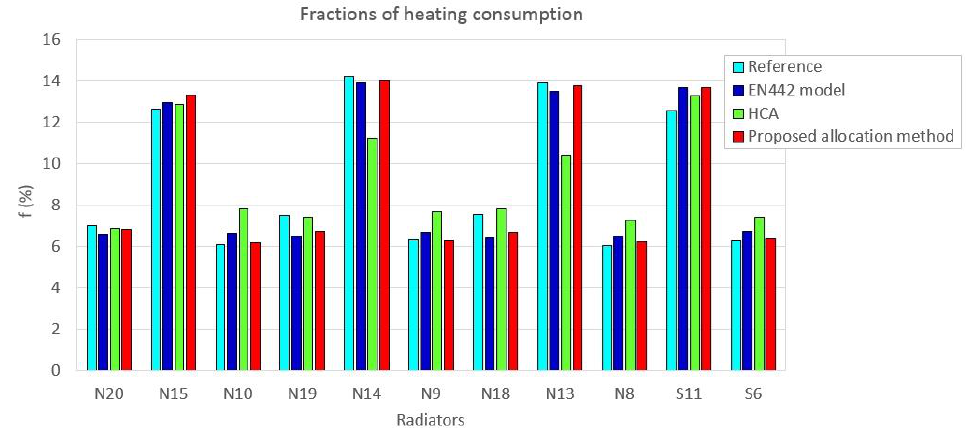
Figure 9. Fractions of heating consumption associated with water radiators. HCA, Heat Cost